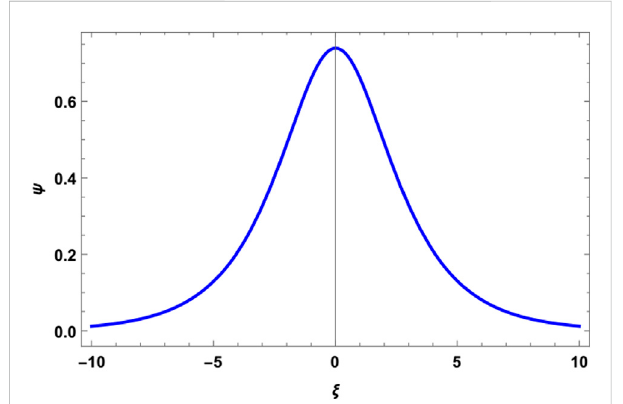
FIGURE 5 Soliton pro fi le for plasma parameters α =0.1, β =0.026, γ =0.7, δ =0.01, μ =0.2, ] =0.8, and m =1. Here, A > 0 and 2 m 2 − 1 > 0.